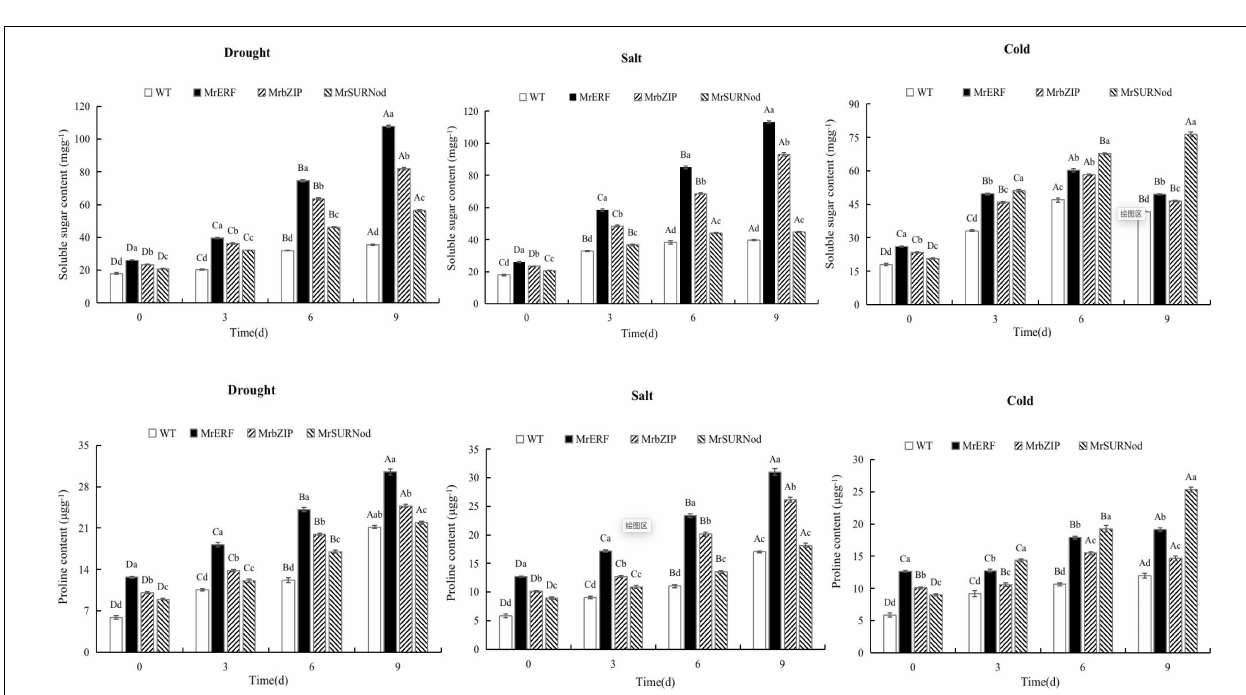
FIGURE 9 | Effects of different stresses on osmotic adjustment substance of tobacco. Different capital letters indicate significant differences under different treatments, and different lowercase letters indicate significant differences among different transgenic lines in the same treatment ( P < 0.05).